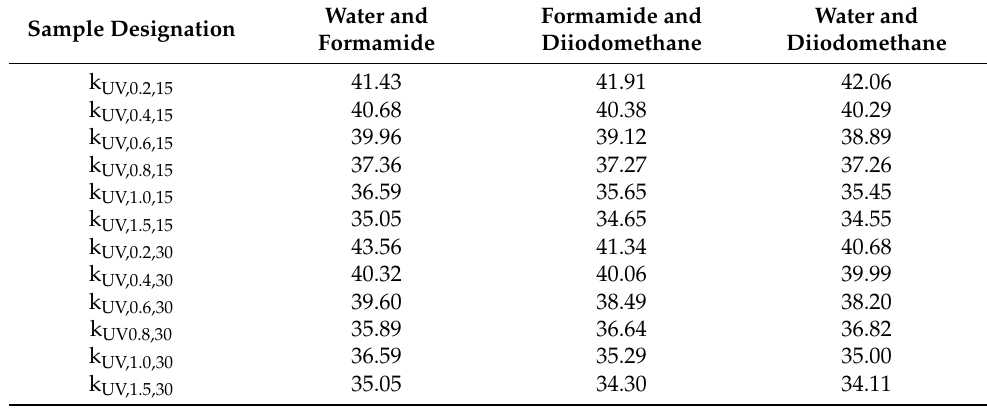
Table 5. Surface energy (mJ · m − 2 ) using water, formamide and diiodomethane as probe liquids.